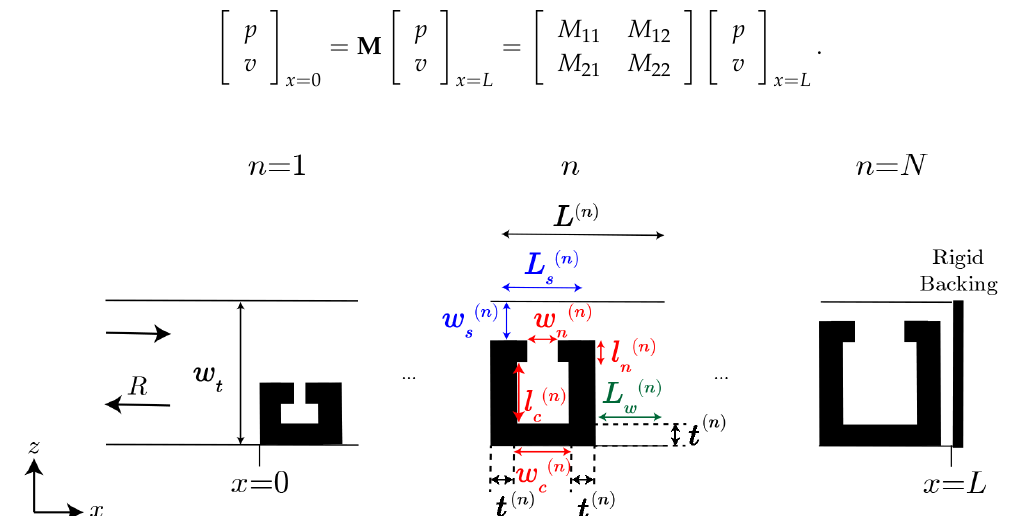
Figure 2. Schematic diagram of a system of N building blocks made of a Helmholtz resonator with a cavity ending on a rigid backing. Description of the geometrical parameters of the system used in Section 2.2. The geometrical parameters corresponding to the Helmholtz resonator are indicated in red, those corresponding to the slit are indicated in blue, and those corresponding to the waveguide are indicated in